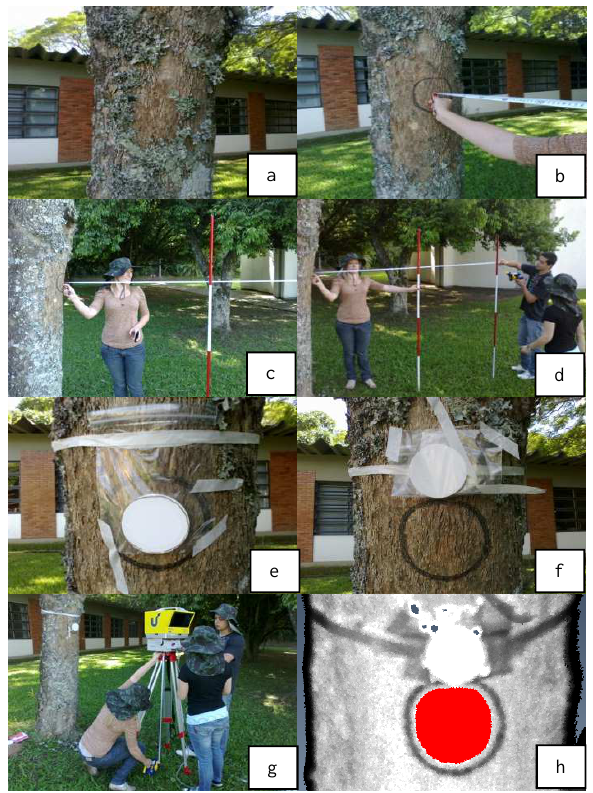
Figure 2. Mosaic of pictures showing the procedures of acquisition of the intensity data as a function of distance and type of targets. (a) Tree before cleaning. (b) Tree and the target demarcated after cleaning. (c and d) Marking the distances. (e and f) Representation of the target in the trunk and Spectralon ® 99%. (g) Measuring the height of park equipment for maintaining the viewing geometry. (h) Points of interest enhanced in red in the point